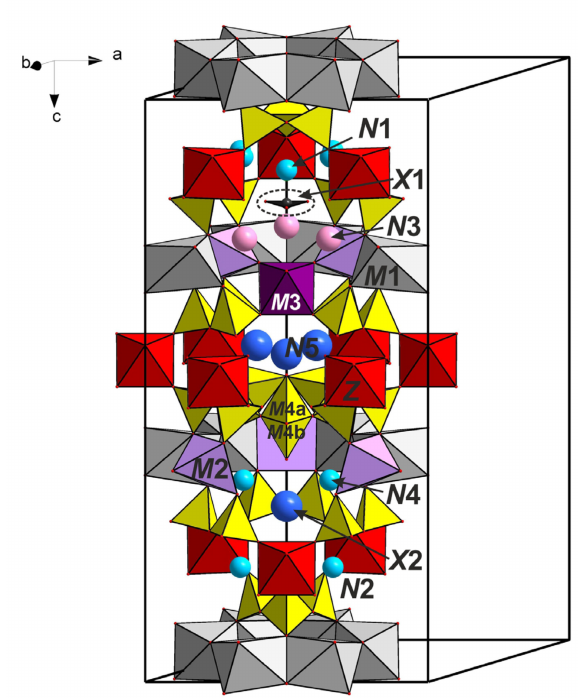
Figure 4. The general view of the crystal structure of odikhinchaite (the unit cell is